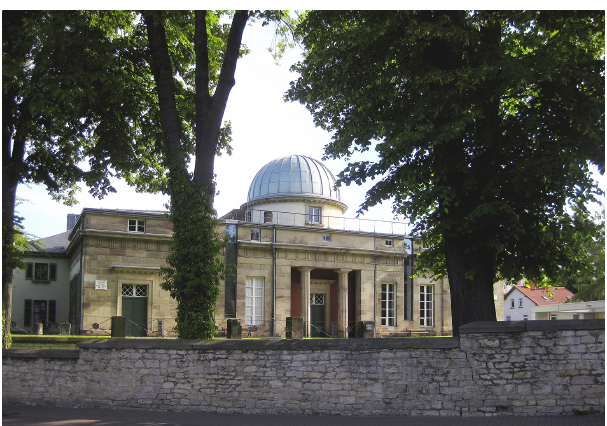
Figure 2. Gauss’s former observatory, the “Sternwarte Göttingen” (photograph by the